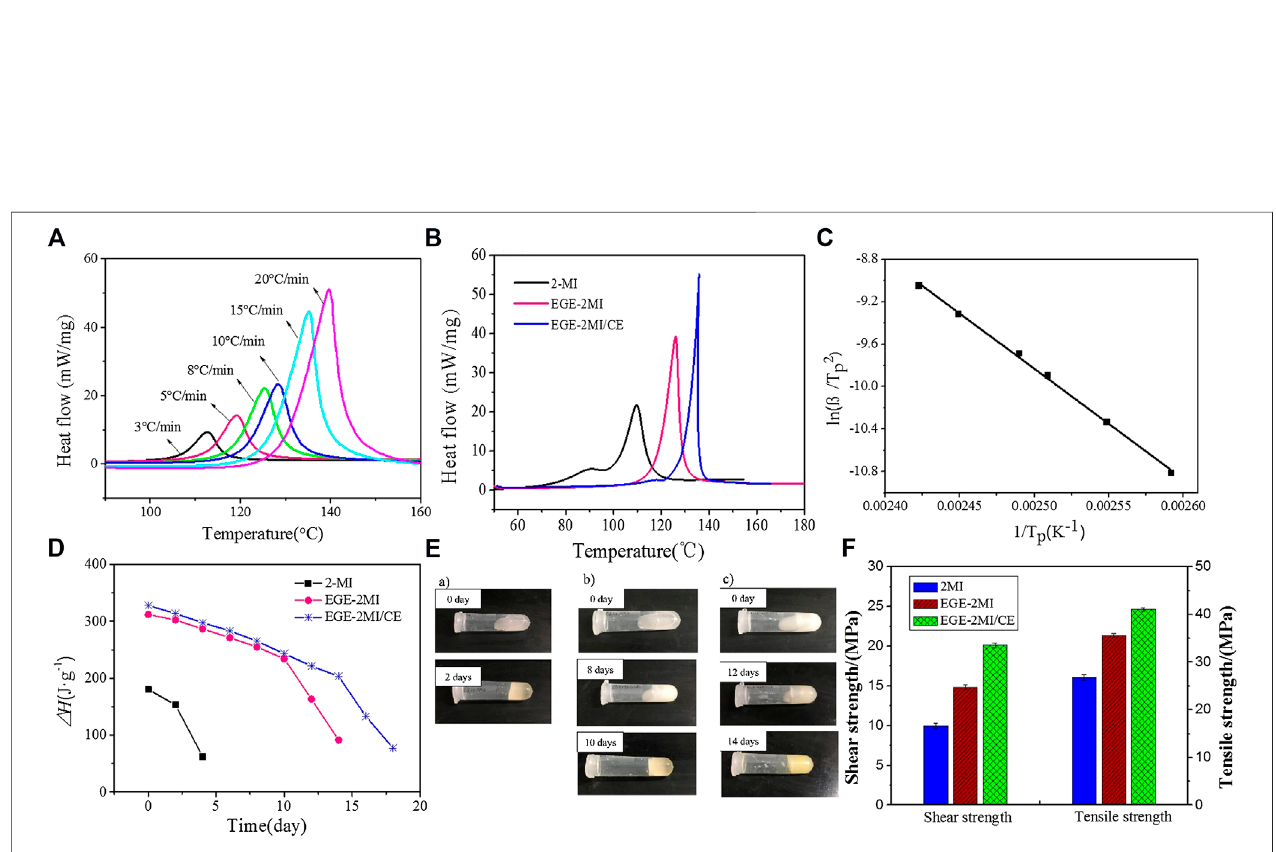
Frontiers in Materials |